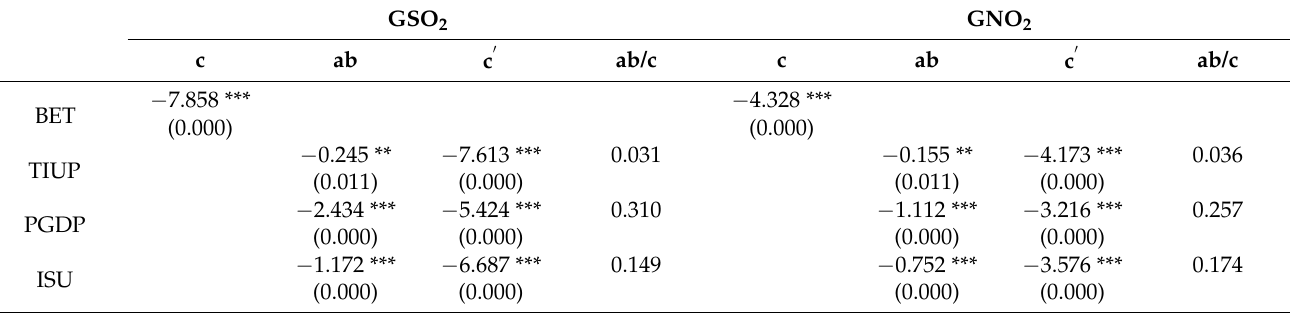
Table 6. Mediating effect on GSO 2 and GNO 2